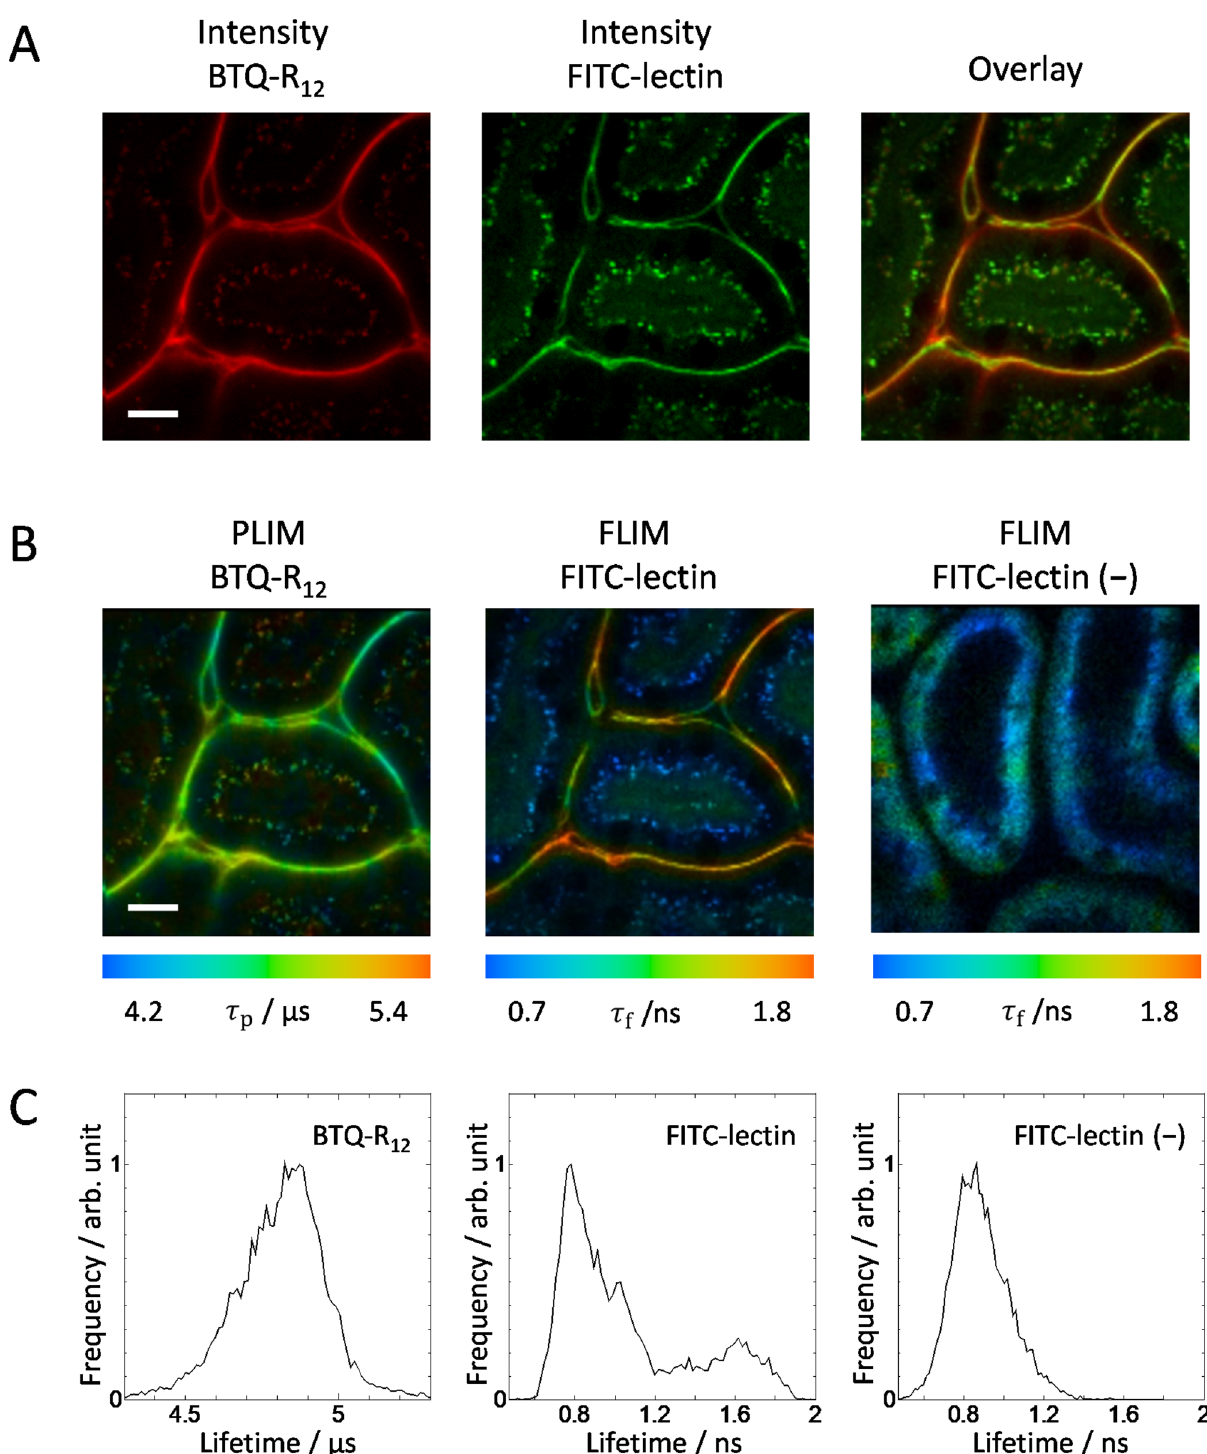
Figure 4. Luminescence intensity images ( A ) and PLIM or FLIM images ( B ) of mouse kidney at 1.5 h after intravenous injection of BTQ-R 12 (100 nmol) and FITC-lectin (1 mg/mL, 50 μL). The right panel in ( A ) is the overlay image. A FLIM image of unstained renal cortex is shown in the right panel in ( B ). λ exc : 488 nm, λ em : > 590 nm (BTQ-R 12 ), 510–560 nm (FITC-lectin). Scale bar 20 μm. ( C ) Distribution histograms of the luminescence lifetimes for the PLIM and FLIM images in ( B